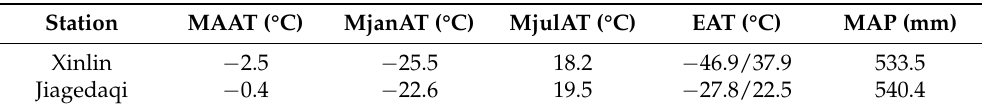
Table 1. Air temperature and precipitation data at Xinlin and Jiagedaqi Meteorological Station along the CRCOP route in permafrost zones from 1972 to 2020.